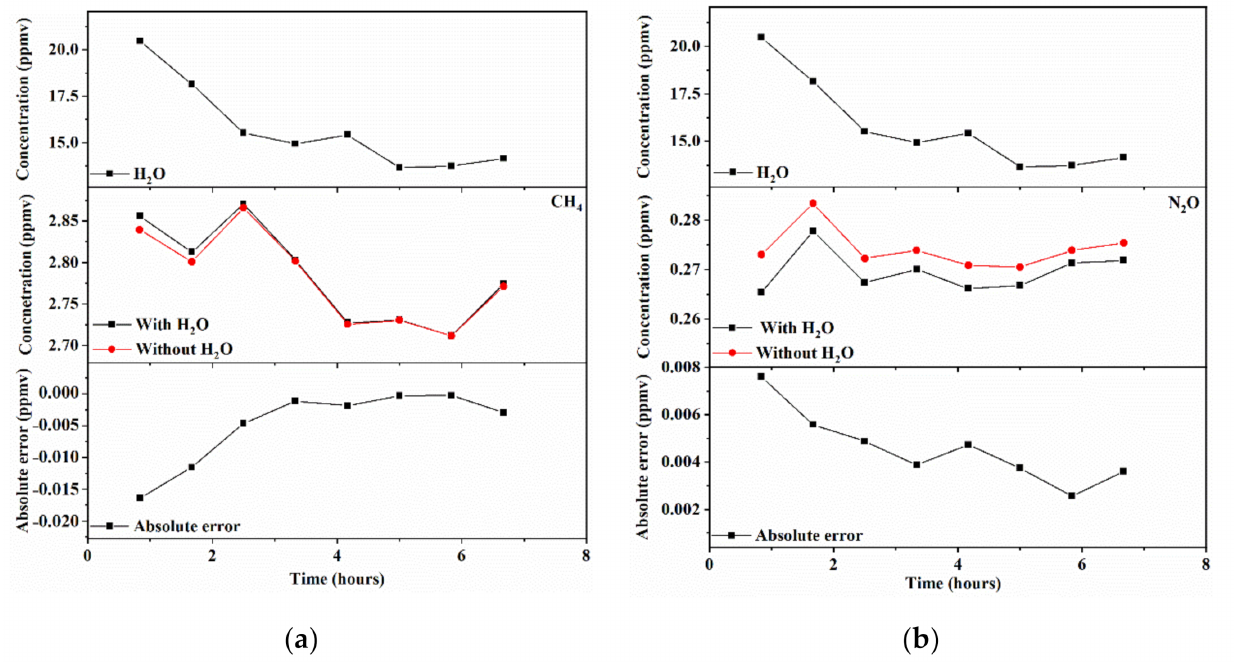
Figure 7. The differences of ( a ) CH 4 and ( b ) N 2 O concentrations between that determined with and without simultaneously determining the H 2 O concentration for flowing